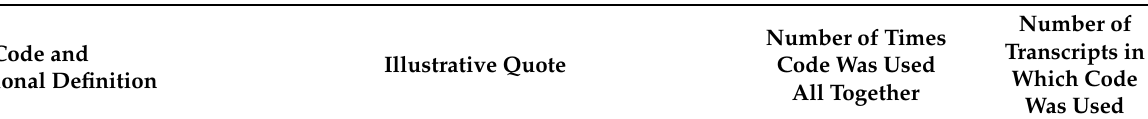
Table 5. Summary of participant interview transcript codes, definitions, and